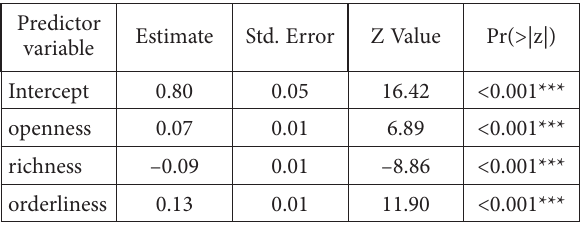
Table 4. The output of the final GLM models for “coherence ~ openness + richness +